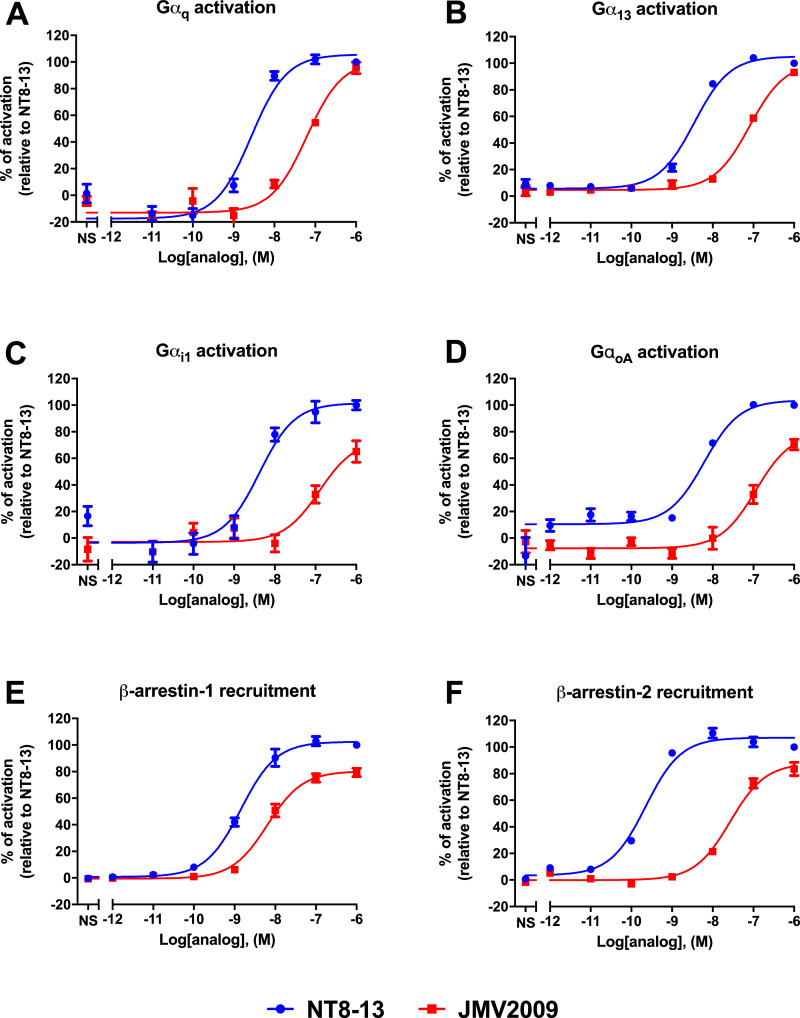
Effect of NT(8–13) and JMV2009 on NTS1 signalling. Activation of Gαq (A), Gα13 (B), Gαi1 (C), and GαoA (D) after stimulation of CHO-K1 cells expressing hNTS1 and the G protein BRET-based biosensors. Recruitment of β-arr1 (E), and β-arr2 (F) upon activation of CHO-K1 cells transfected with hNTS1-GFP10 and β-arr1/2-Rluc biosensors.